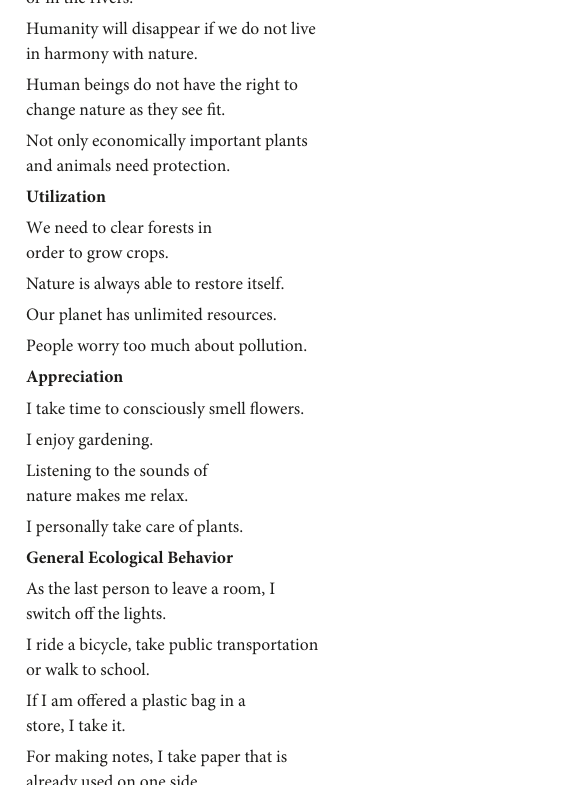
TABLE 1 Listing of the five best item examples of Preservation, Utilization, and Appreciation 2-Major Environmental Values (2-MEV) as well as reported ecological behavior General Ecological Behavior (GEB) with different